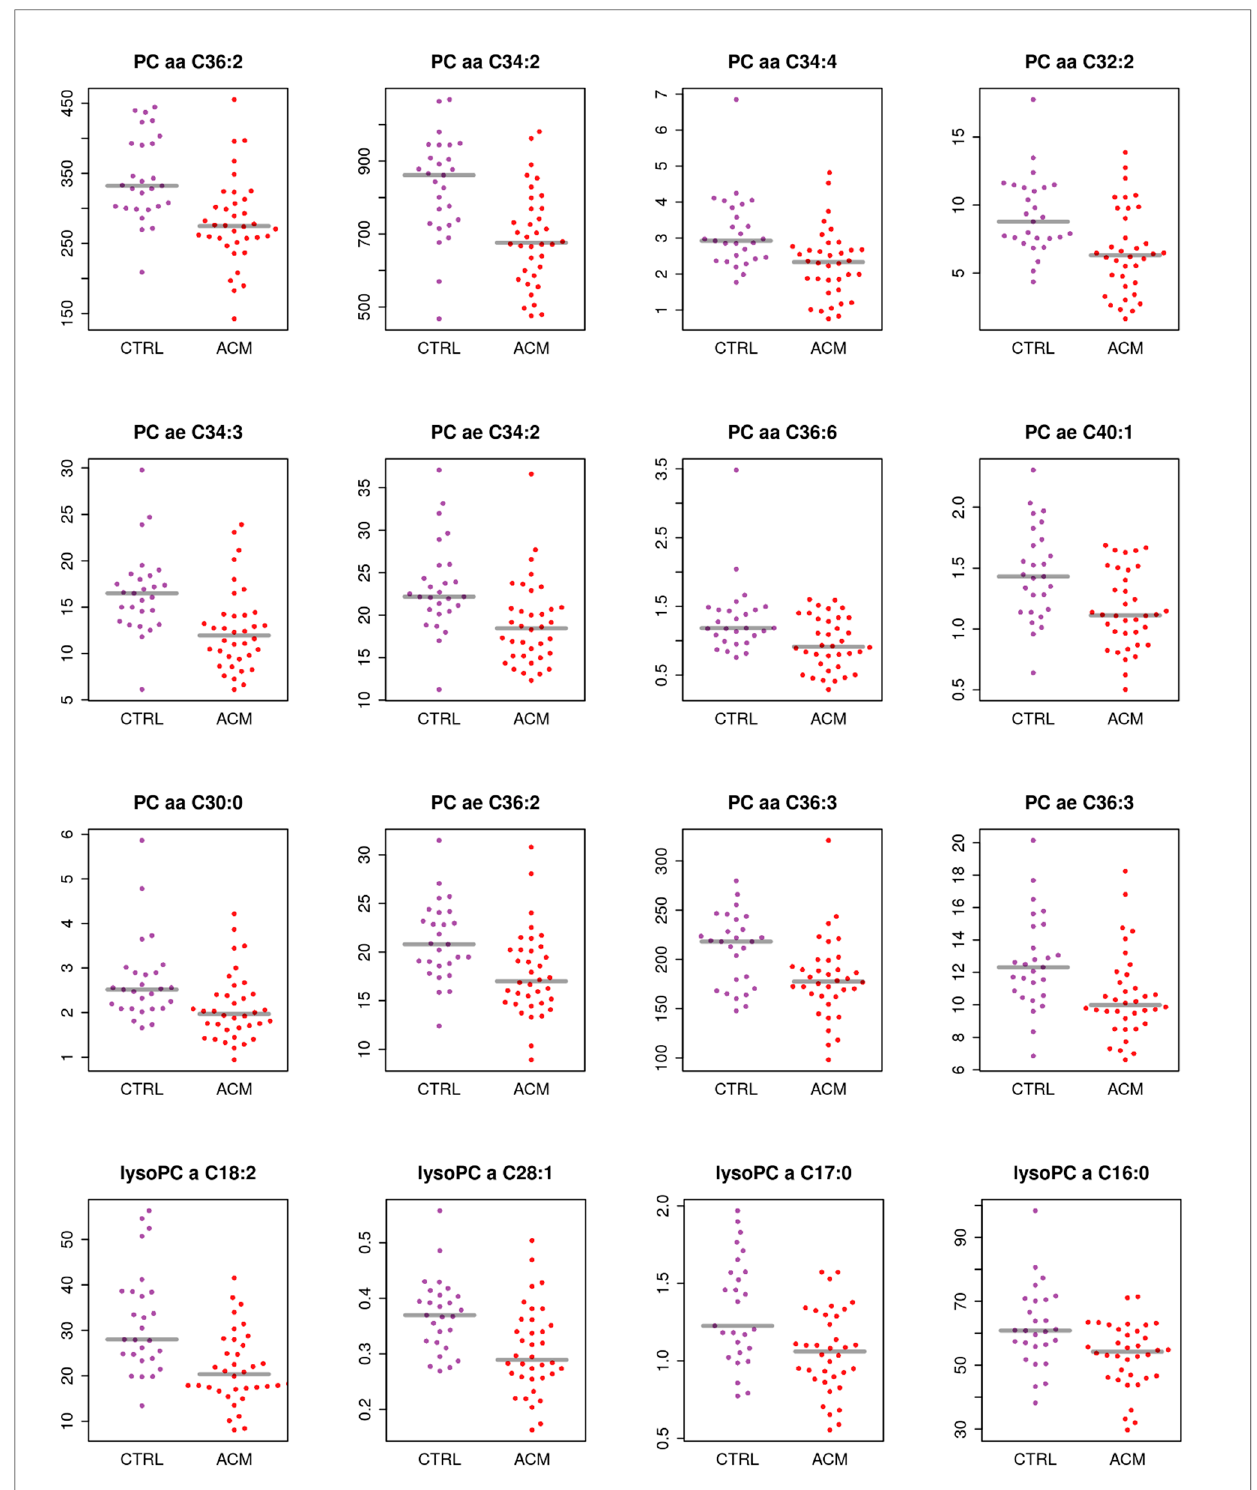
Figure 5. Individual analyte concentrations (adjusted for sex and batch) for glycerophospholipids with significant differences between ACM (red dots) and control samples (purple dots).